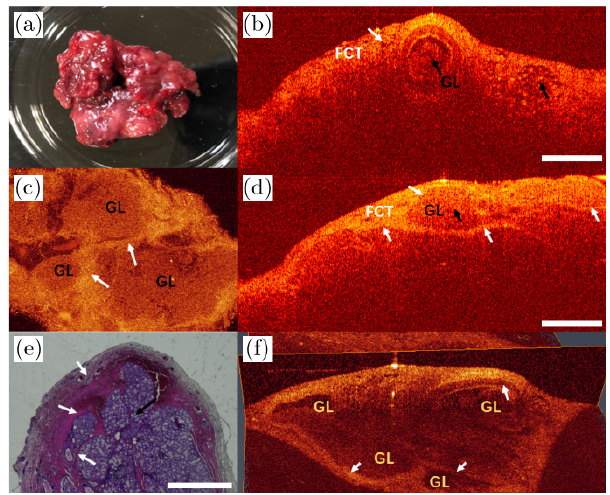
Fig. 9. Images of sublingual gland. (a) Photo of the excised tissue specimen. (b) and (d) The 2D OCT images of two di®erent positions of sublingual gland from the same sample. (c) An en - face image. (e) Its histopathological image. (f) A 3D OCT image. FCT: ¯brous connective tissue and GL: glandular lobule.